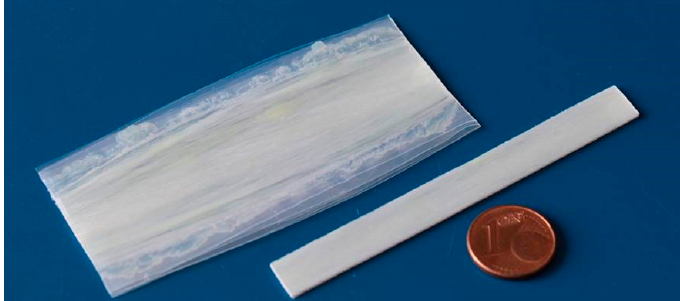
Figure 9. Ultrasonically fabricated GFRP made from four layers of glass fiber roving with a thickness of 200 µ m each and five layers of PA film with a thickness of 100 µ m